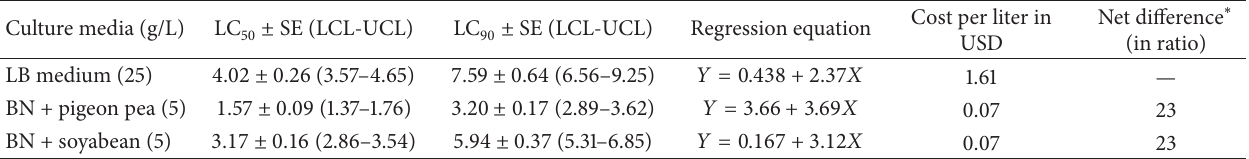
Table 3: Toxic effect of Bt 𝑠𝑣2 on different media against IVth instars larvae of Aedes aegypti and comparative cost analysis for production of toxin.